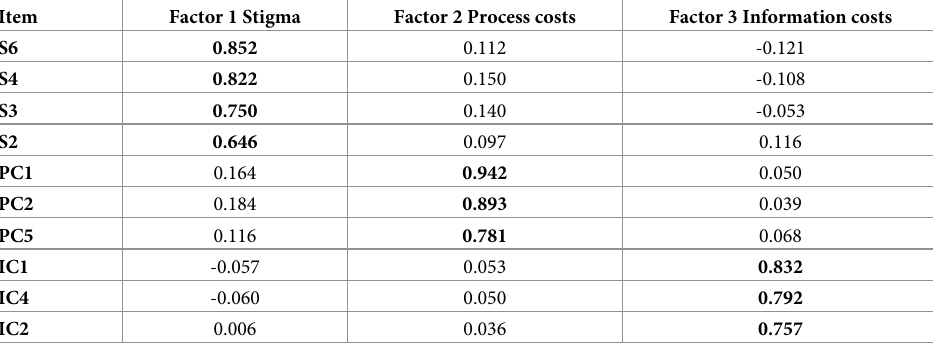
Table 3. Exploratory factory analysis of the claiming costs scale– 10 items (Sample 1, n = 141).